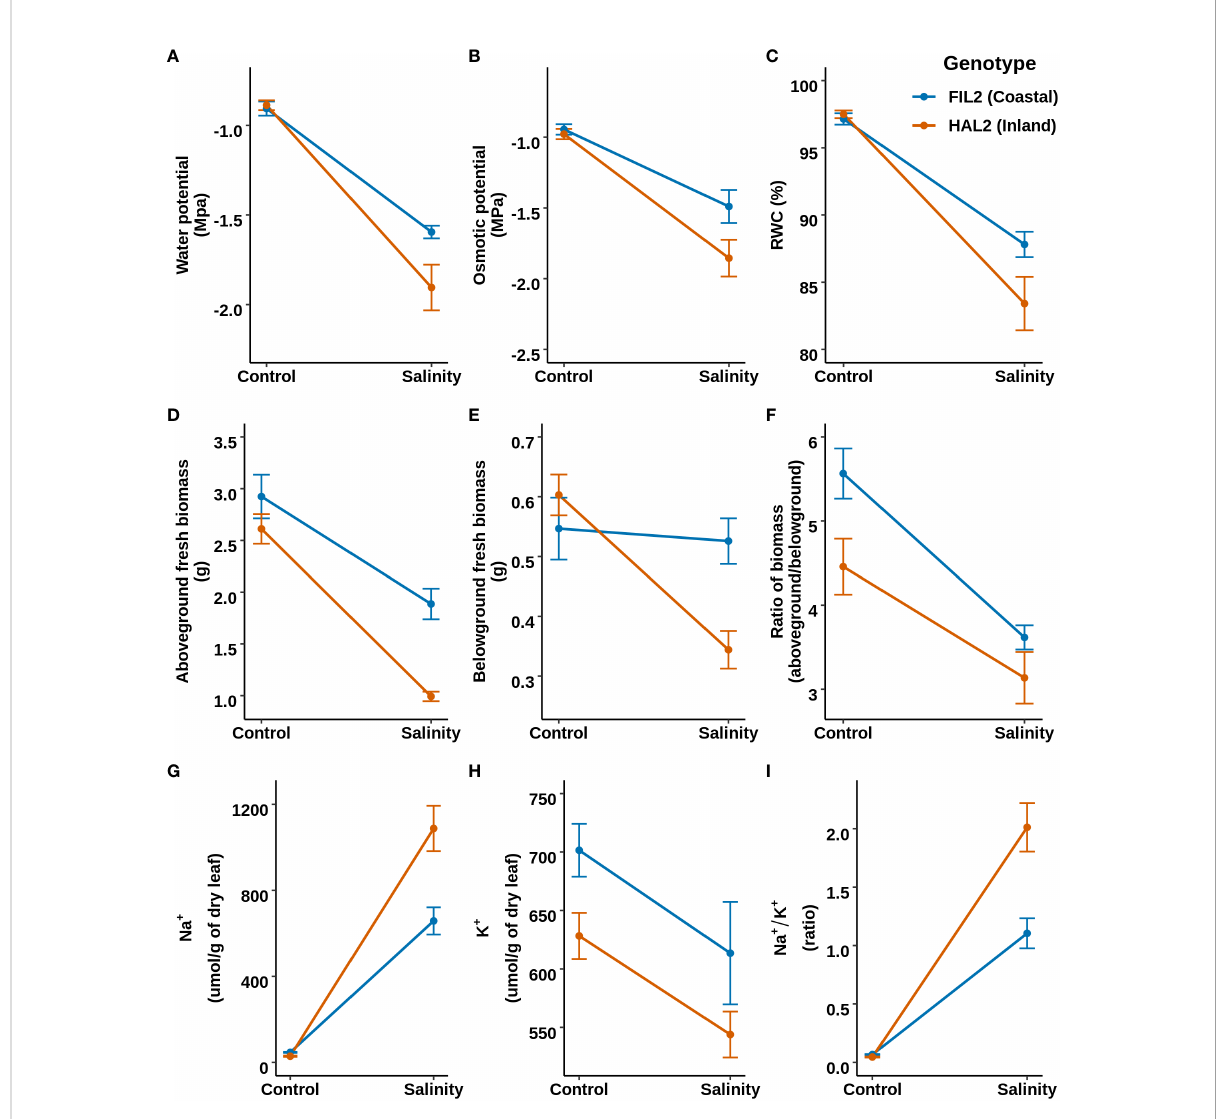
FIGURE 2 Response of mature plants to salinity based on representative genotypes of coastal (FIL2) and inland (HAL2) ecotypes. Top, middle, and bottom panels represent the reaction norm plots for leaf water status, plant growth, and leaf sodium and potassium ion homeostasis related traits, respectively. (A – C) Water potential, Osmotic potential, and Relative water content respectively. (D – F) represents the reaction norm of Aboveground fresh biomass, Belowground fresh Biomass, and their ratio (aboveground/belowground). (G – I) represents leaf sodium content (Na + ), Leaf potassium content (K + ), and the ratio of leaf sodium to potassium content (Na + /K +